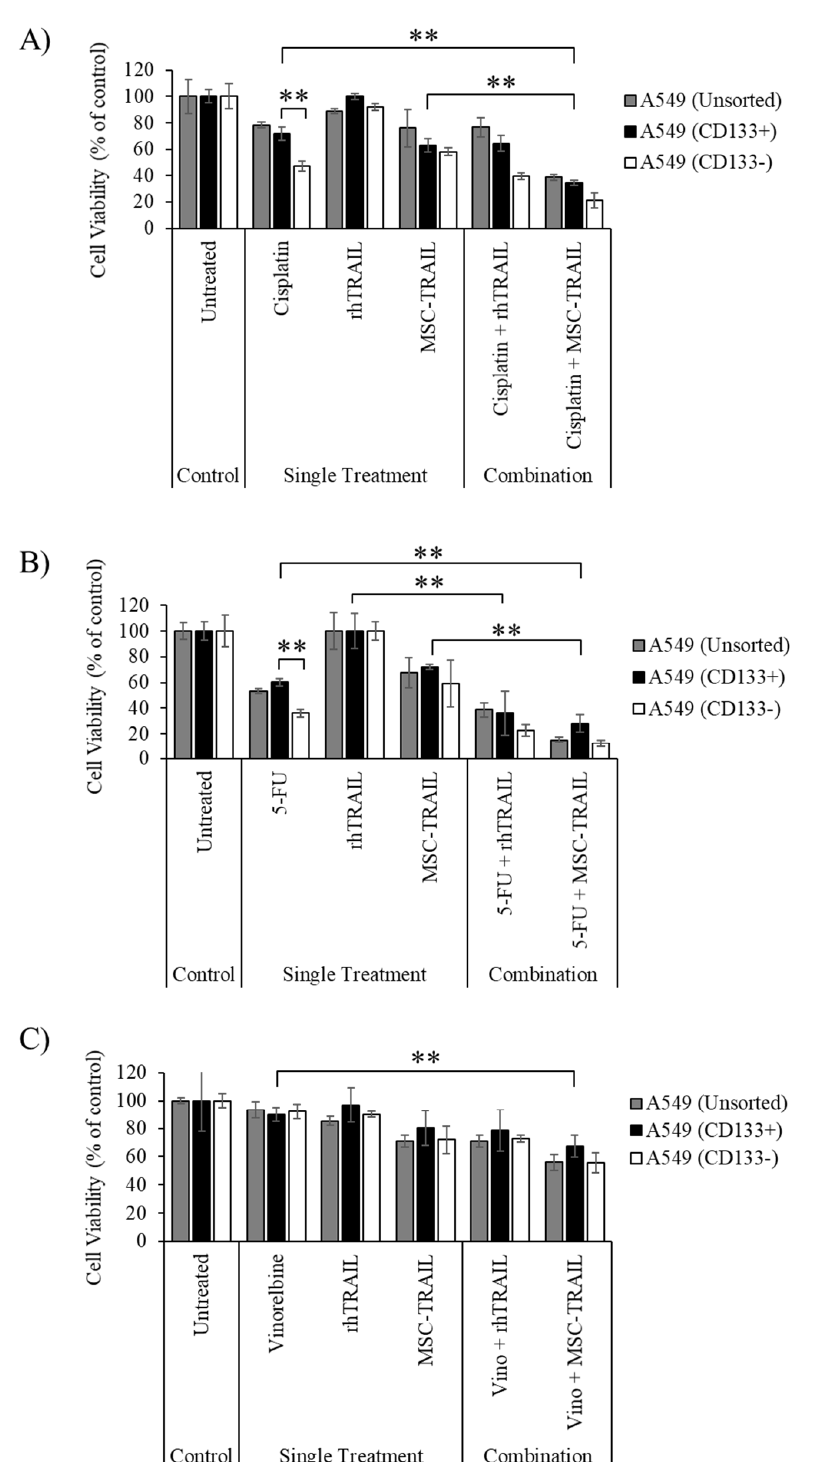
Figure 3. The chemo-sensitization effect in A549-derived CD133+ CSCs to MSC-TRAIL. ( A , B ) Chemo-sensitization of A549-derived CD133+ CSCs using either cisplatin or 5-FU significantly increased the effect of MSC-TRAIL in killing CSC. ( C ) The combination between MSC-TRAIL and vinorelbine appears to have no significant effect in enhancing the inhibition of CSCs when compared to MSC-TRAIL alone, as no changes in cell viability were detected between the two groups (** p < 0.001; t -test, n = 3). 5-FU, 5-fluorouracil; Vino, vinorelbine.